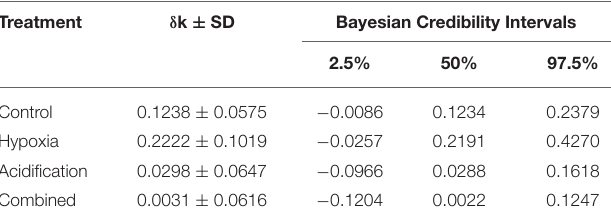
TABLE 2 | Bayesian Confidence Intervals indicating the tendency of the fish to remain close to their refuge after introduction of a predator: a δ k > 0 indicates the tendency to move to and remain close to the refuge; a δ k around 0 means the movement pattern approaches a (i.e., unbiased) random walk, and a negative δ k shows that the fish tend to avoid the shelter.